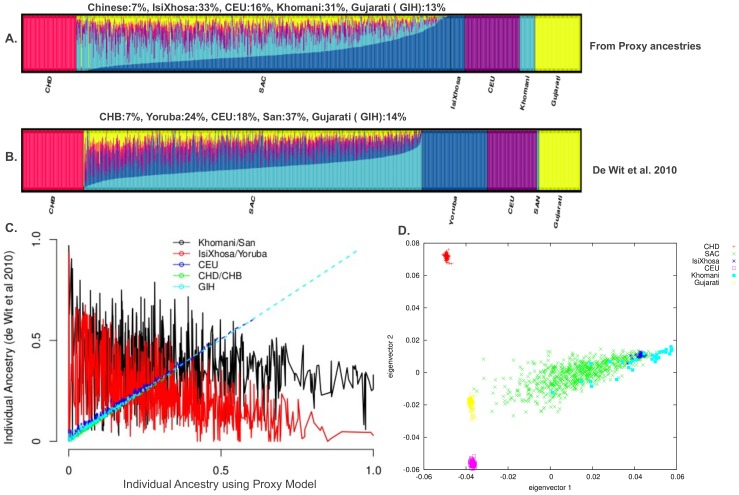
Individual ancestry proportion and PCA based on 47863 autosomal SNPs in the SAC data.(A) Population clustering analysis of the SAC using both the current selected best proxy ancestors as reference panel (First top figure) and reference panel used in De Wit et al.(B) Plot showing individual’s ancestry difference between panel of selected best proxy ancestral population of the SAC and the panel of reference population used in De Wit et al. [19]. This plot indicates a large difference of African ancestry of the SAC between the two analyses, suggesting the choice of African Ancestry of the SAC is critical and sensitive due to the diversity and closely relatedness of most African populations. (C) PCA on autosomal SNPS. Both first and second principal components show great genetic differentiation between the five proxy ancestral groups, where the SAC is in the convex hull of them.